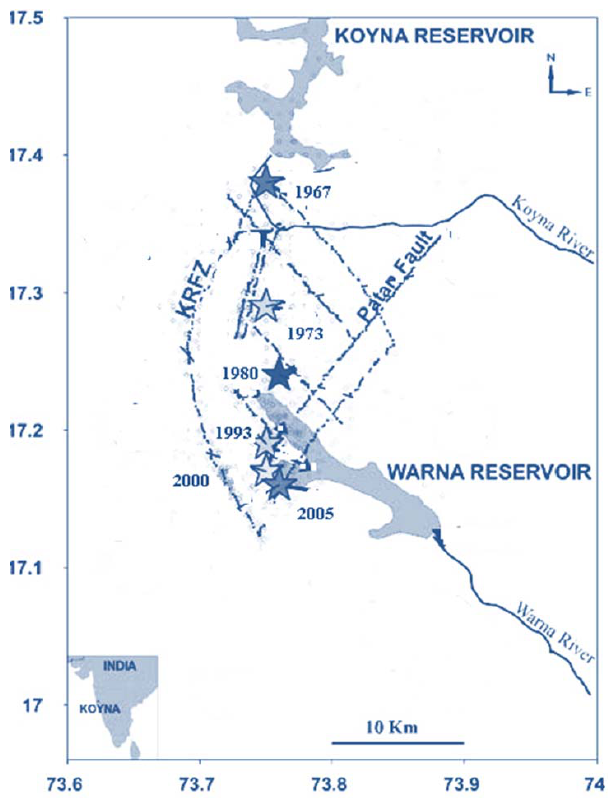
Fig. 1. Location of the Koyna–Warna region. Stars denote the location of the earthquakes of magnitude greater than 5.